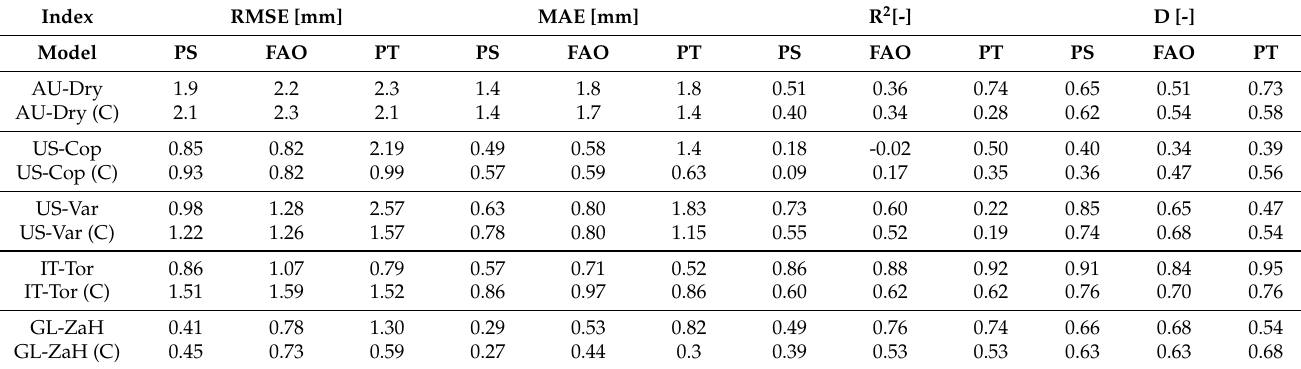
Table 6. Daily values of GOFs obtained for each site and for the uncalibrated and calibrated (C)